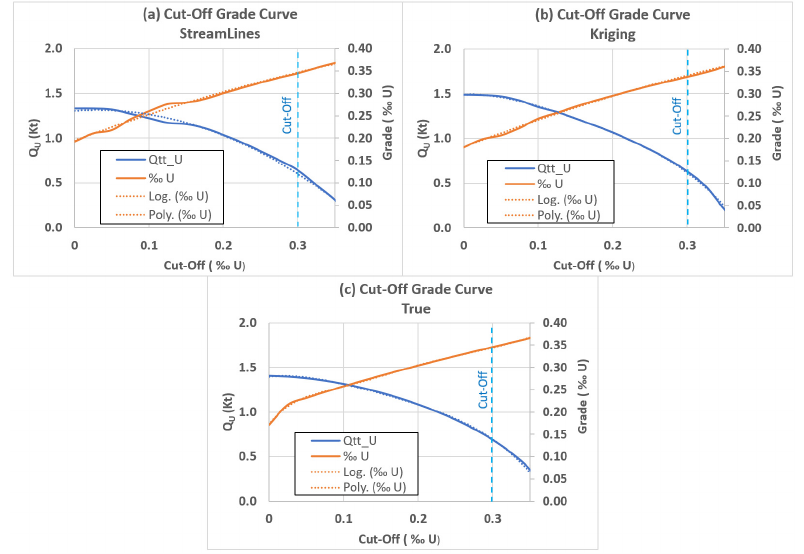
Figure 16. Grade cut-off diagrams with resources (blue) and grades (orange) over cut-offs ranging from 0 to 0.35 ‰U, together with fitted trend lines (dotted) and exploitation cut-off at 0.3‰U (blue vertical dashed line) for ( a ) streamline-based proposed method; ( b ) kriging method; ( c ) true re- sources taken from the simulated deposit.